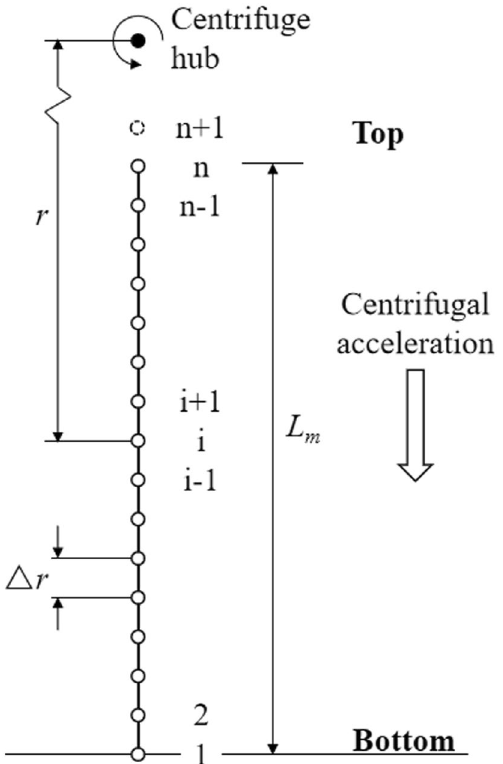
Figure 2. Finite-difference grid blocks for one-dimensional centrifugal model, the ( n + 1)th node is a virtual one used for boundary condition at the